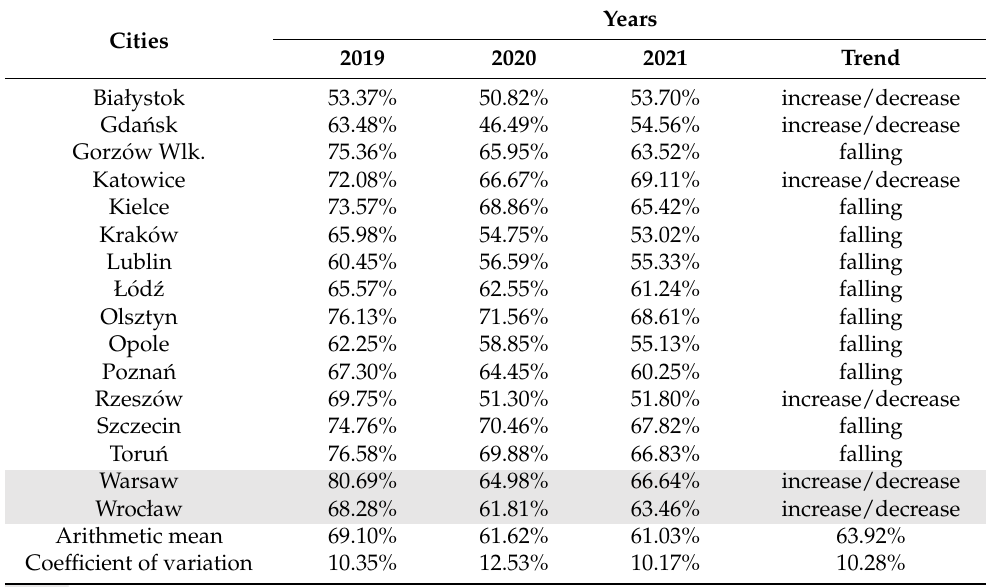
Table 3. Share of mixed waste in total waste per capita from 2019-2021 [in %].